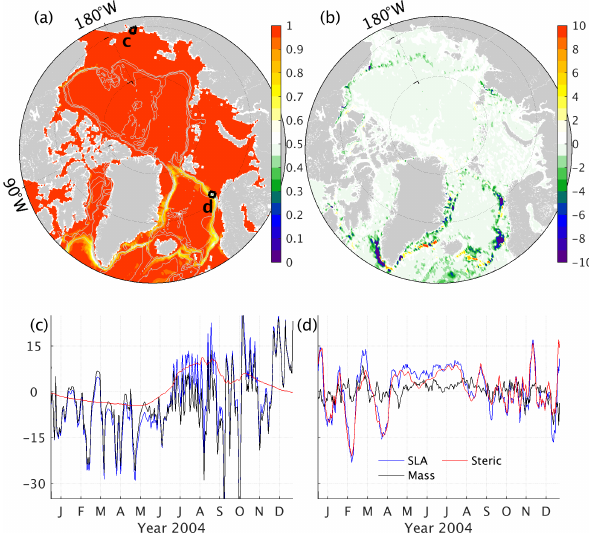
Figure 5. (a) Amplitude and (b) phase of the transfer function between sea level anomaly and bottom pressure anomaly at peri- ods of < 30d. Time series of sea level anomaly (blue lines), mass component (black lines), and steric component (red lines) averaged (c) in the East Siberian Sea (black box c in panel a ) and (d) along the NwAC (black box d in panel a